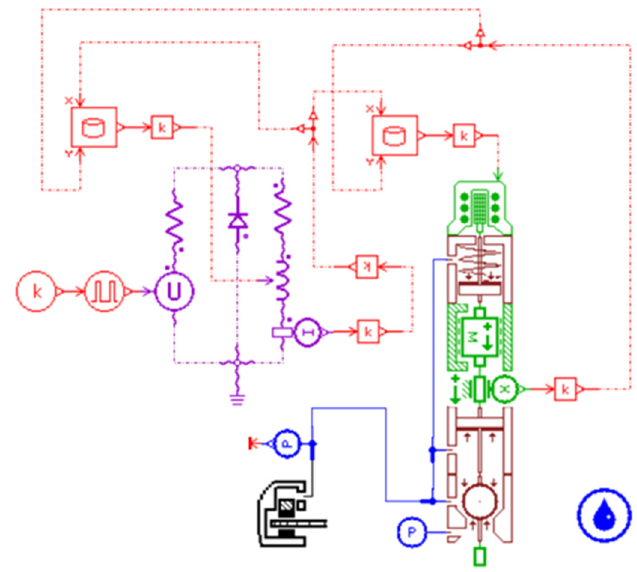
Figure 10. The AMESim model of the solenoid valve.